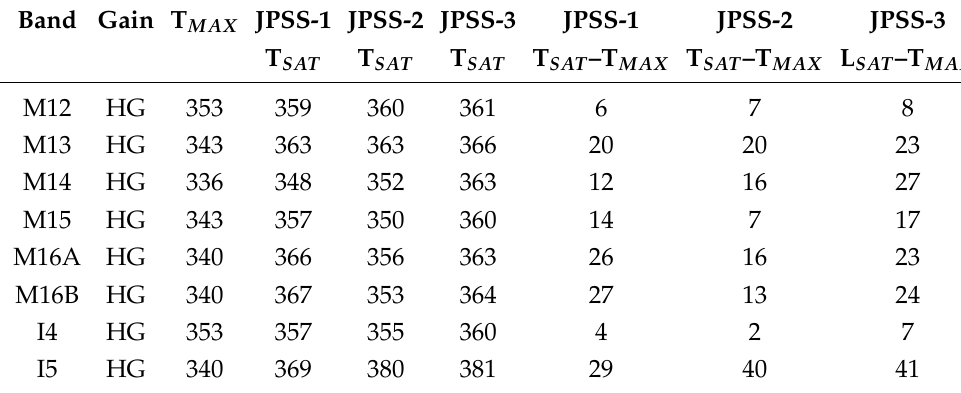
Table 5. JPSS-3 VIIRS TEB T SAT relative to the sensor specification [10]. JPSS-1 and JPSS-2 results are included for comparison.